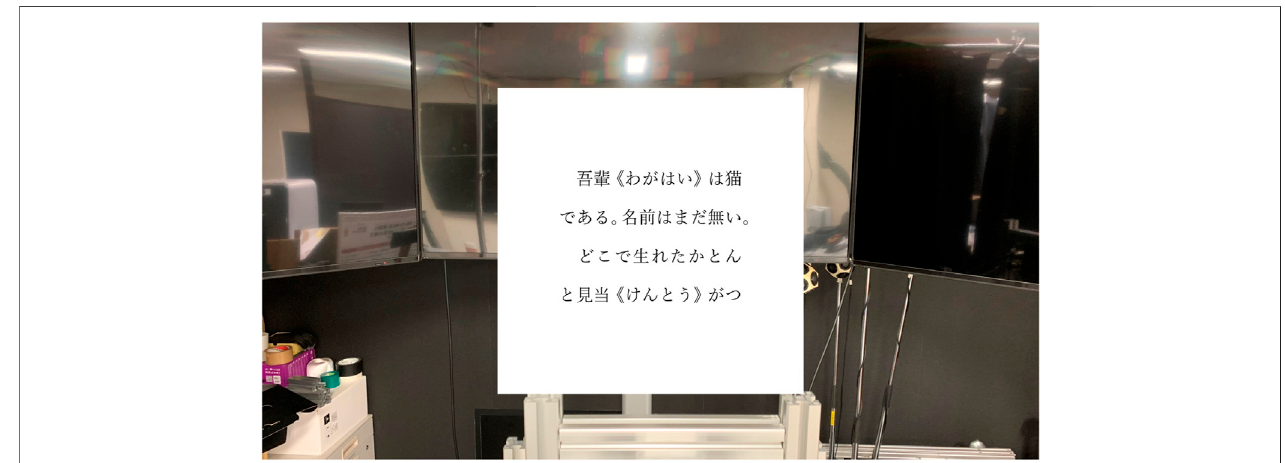
FIGURE 4 | Examples of images in the camera background